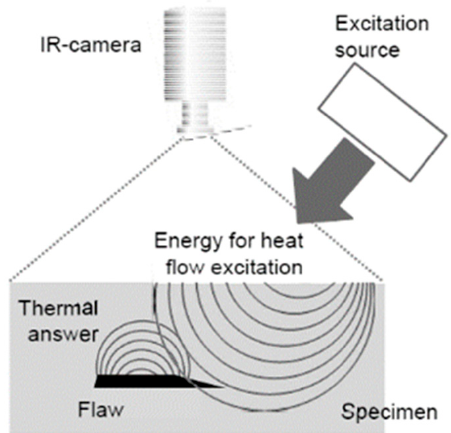
Figure 16. A schematic of active thermography [106].